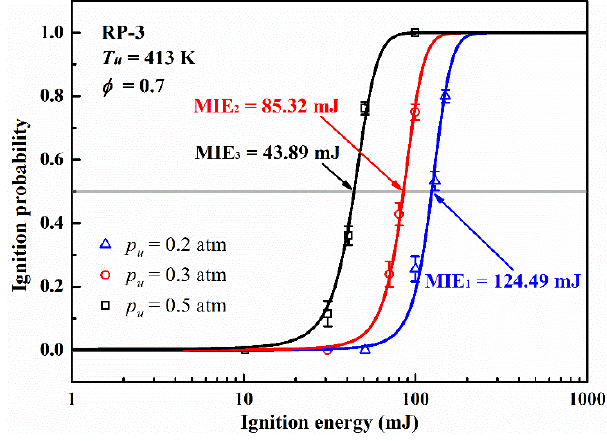
Figure 5. Effects of initial pressure on the ignition probability. T u = 413 K, ϕ = 0.7, Z H2O = 0%, Z O 2 = 21%).